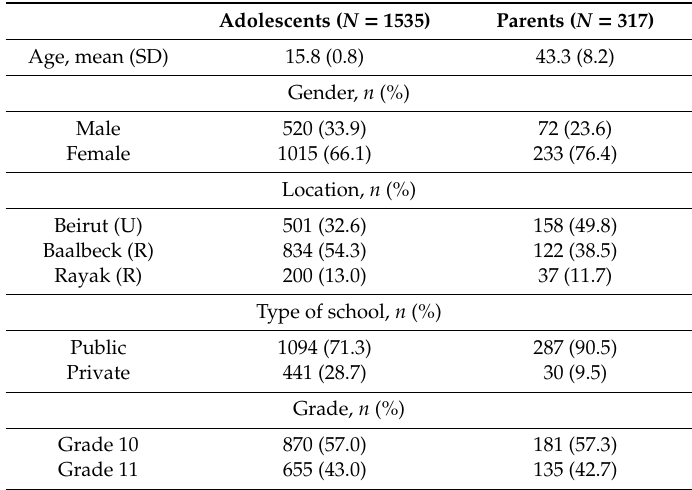
Table 1. Demographic characteristics of the participants.